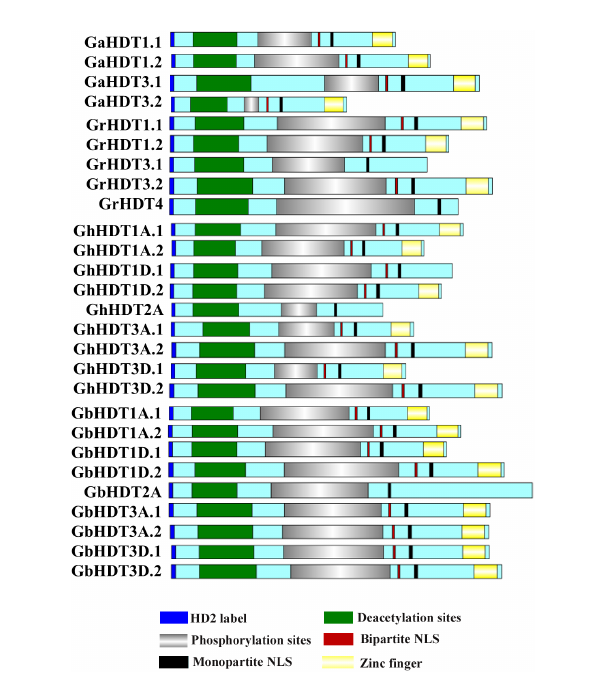
FIGURE 2 Schematic depiction of GaHD2s, GrHD2s, GhHD2s, and GbHD2s. The domain structures of GaHD2s, GrHD2s, GhHD2s, and GbHD2s, drawn using Illustrator for Biological